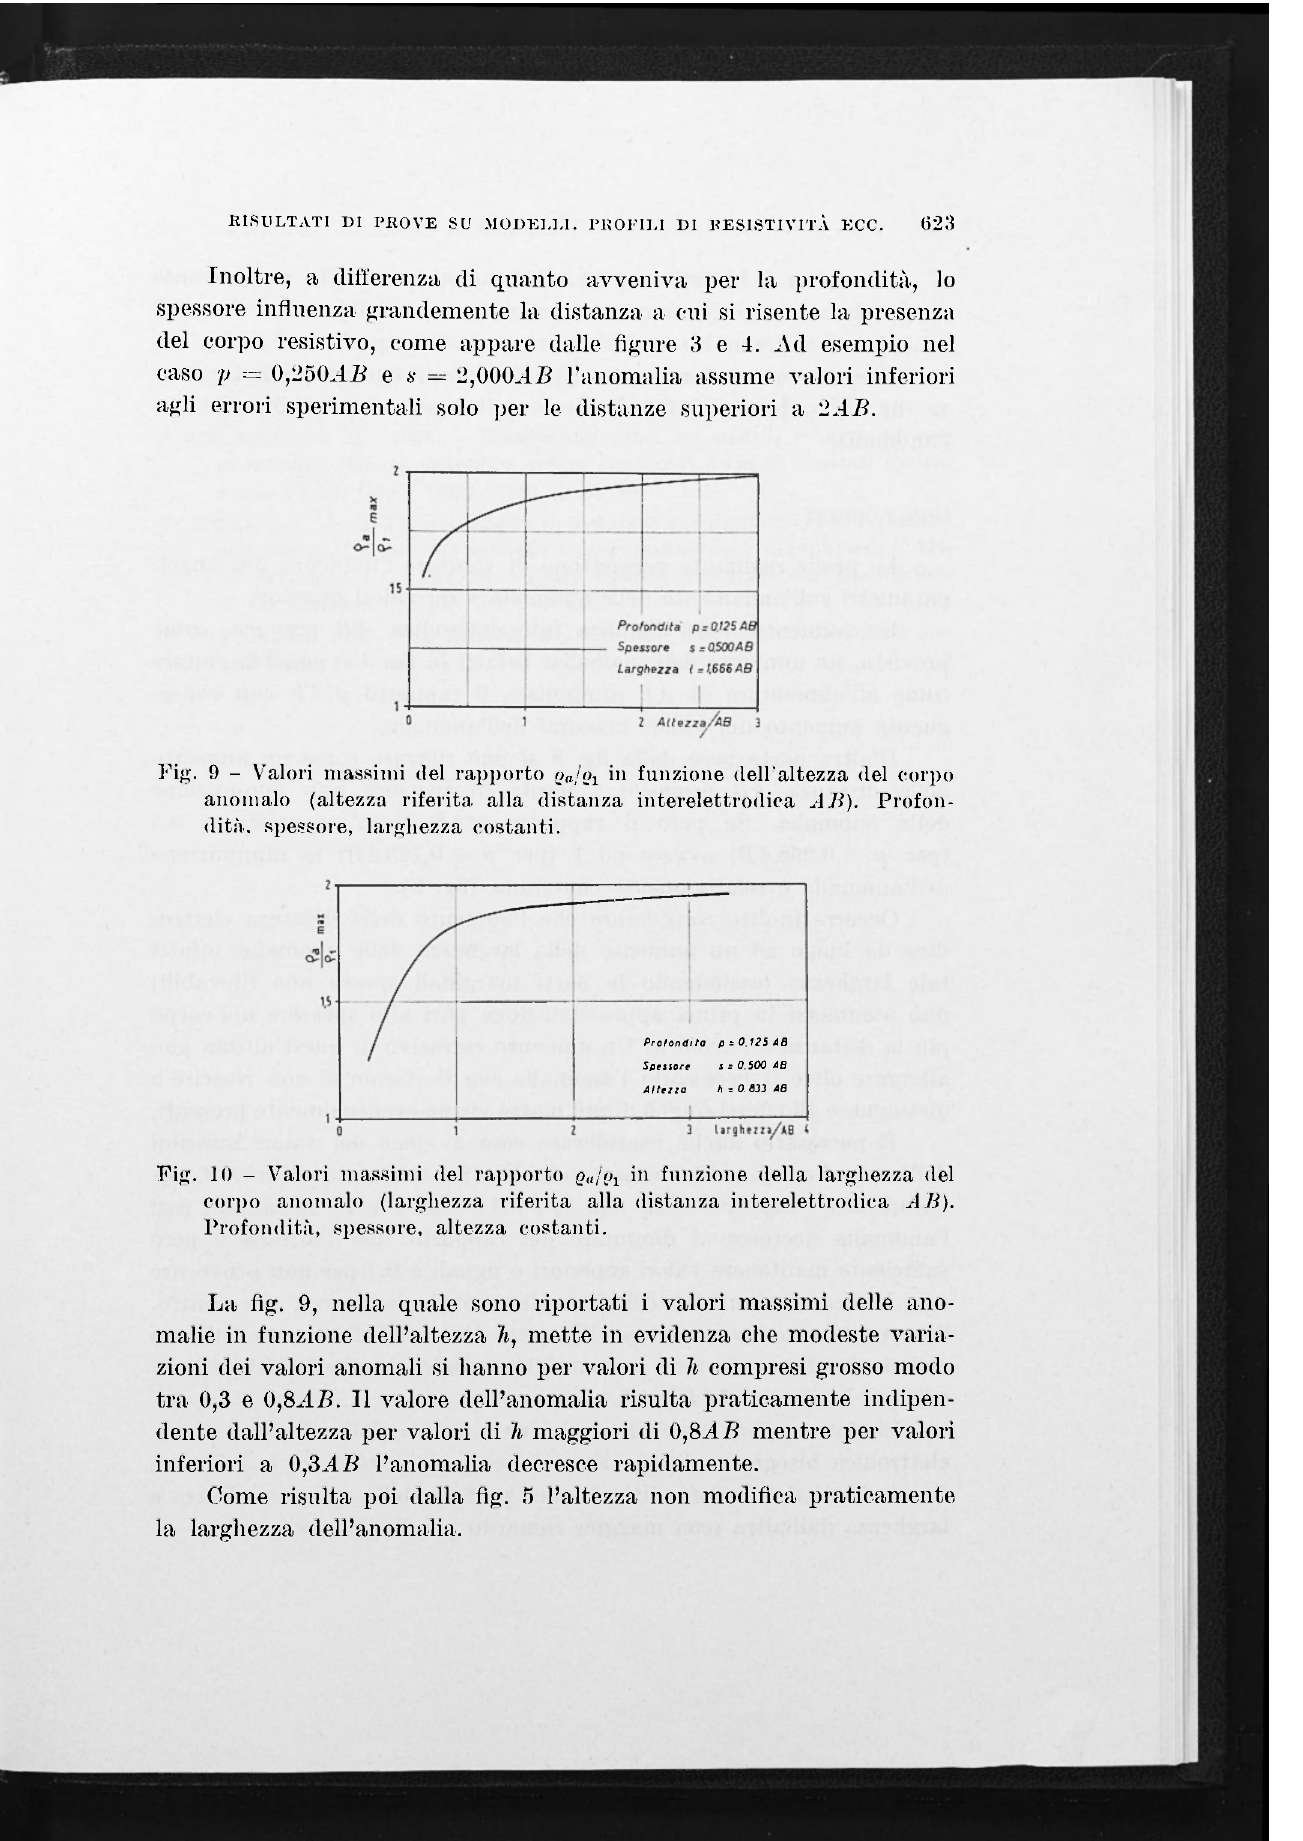
Fig. 10 - Valori massimi del rapporto Q a /(>i in funzione della larghezza del corpo anomalo (larghezza riferita alla distanza interelettrodica